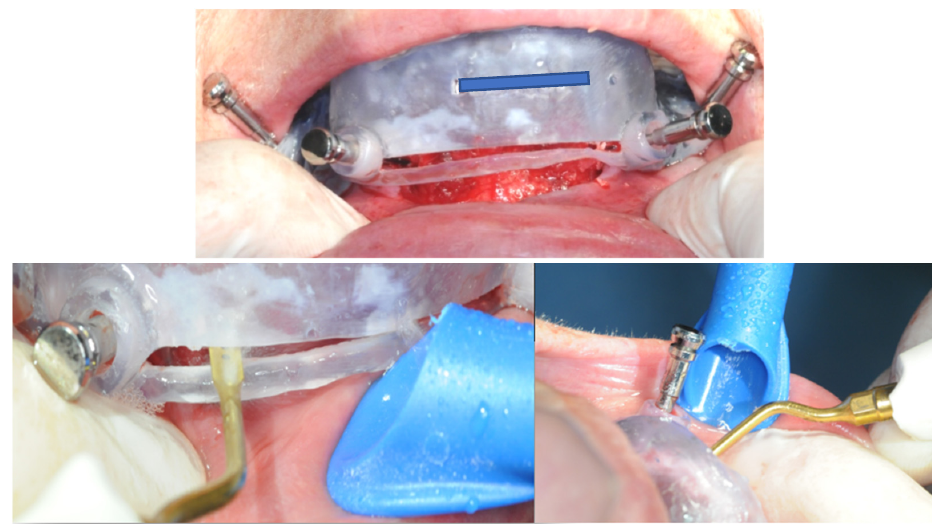
Figure 11. Details of the osteotomy executed with Piezosurgery.